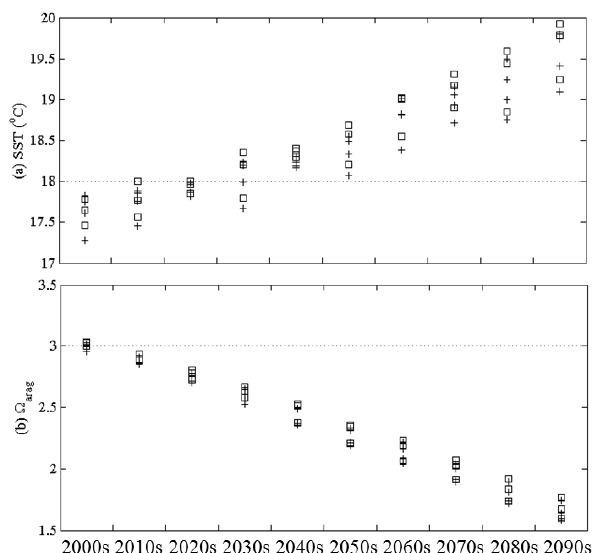
Fig. 6. Decadal-mean (a) SST ( ◦ C) during the coldest months and (b) annual lowest (cid:127) arag (2000s–2090s) at Kushimoto-Shirahama (135.7 ◦ E, 33.5 ◦ N) and Tateyama (139.8 ◦ E, 35.0 ◦ N) projected by the four climate models. Squares denote the projected SST and (cid:127) arag at Kushimoto-Shirahama. Crosses show the projected SST and (cid:127) arag at Tateyama. A dotted line in (a) and (b) denotes a SST=18 ◦ C and (cid:127) arag = 3 line,